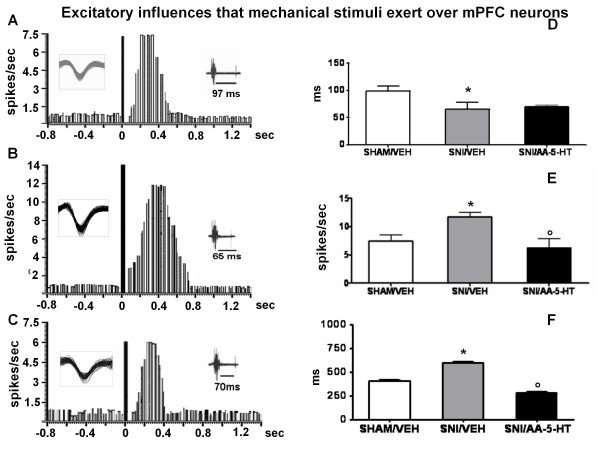
Mechanical stimulation evokes excitatory responses in the PL/IL cortex neurons of BLA → PL/IL (+) neurons. The figure shows different parameters of mechanical stimulus-evoked excitation, including the onset, the frequency and the duration of excitation, in sham and SNI rats treated for 7 days with vehicle (veh) or AA-5-HT (5 mg/kg, i.p.). "A", "B" and "C" show a representative ratemater record of a mechanical stimulus → PL/IL (+) neurons of sham/veh, SNI/veh and SNI/AA-5-HT rat. "D","E" and F show the onset, the frequency and the duration (mean ± SEM) of the excitation, respectively, in the different groups of rats. * indicates statistically significant difference versus sham/veh and º versus SNI/veh. P < 0.05 was considered as value of significance and n = 10 was used for each group.